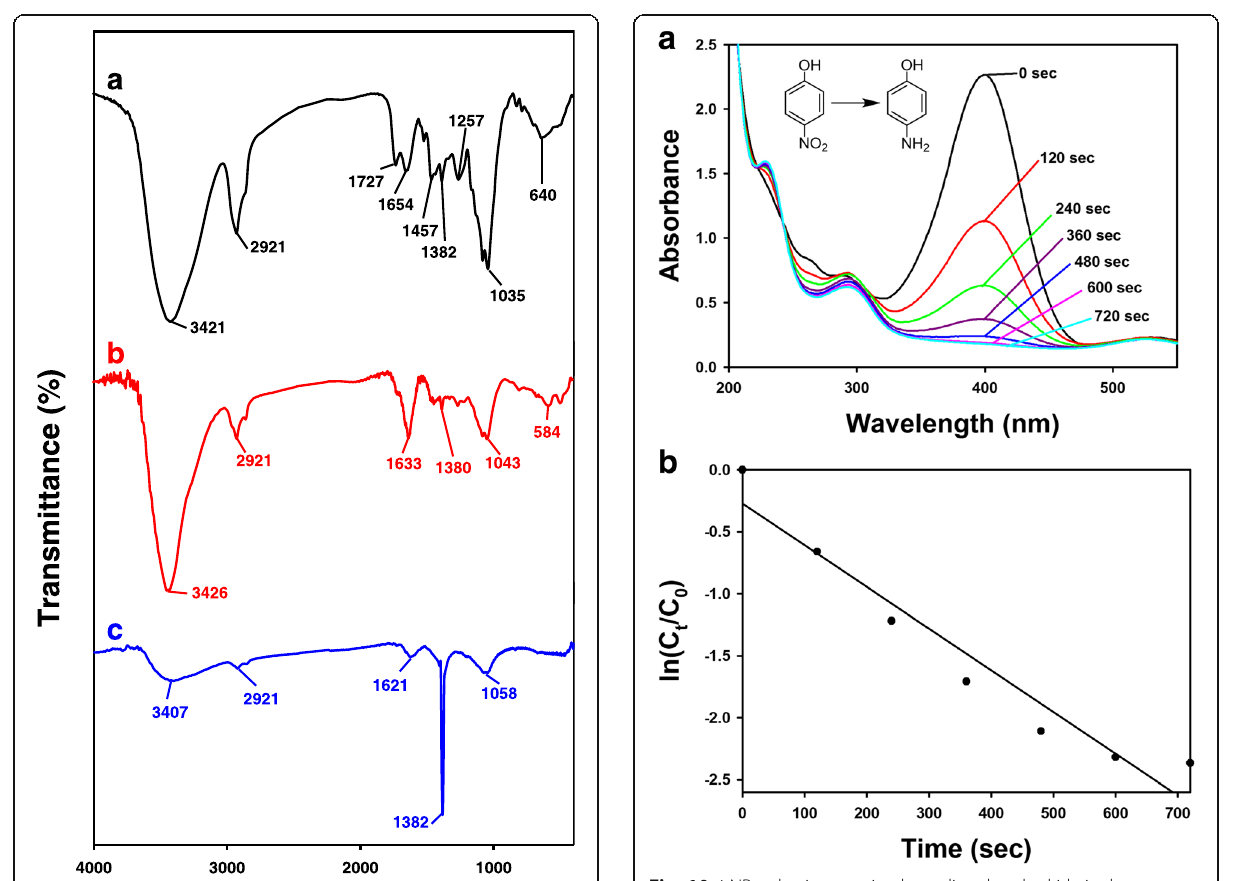
Fig. 10 4-NP reduction reaction by sodium borohydride in the presence of the PD-AuNP catalyst. a UV-visible spectra and b plot of ln( C t / C 0 ) as a function of time